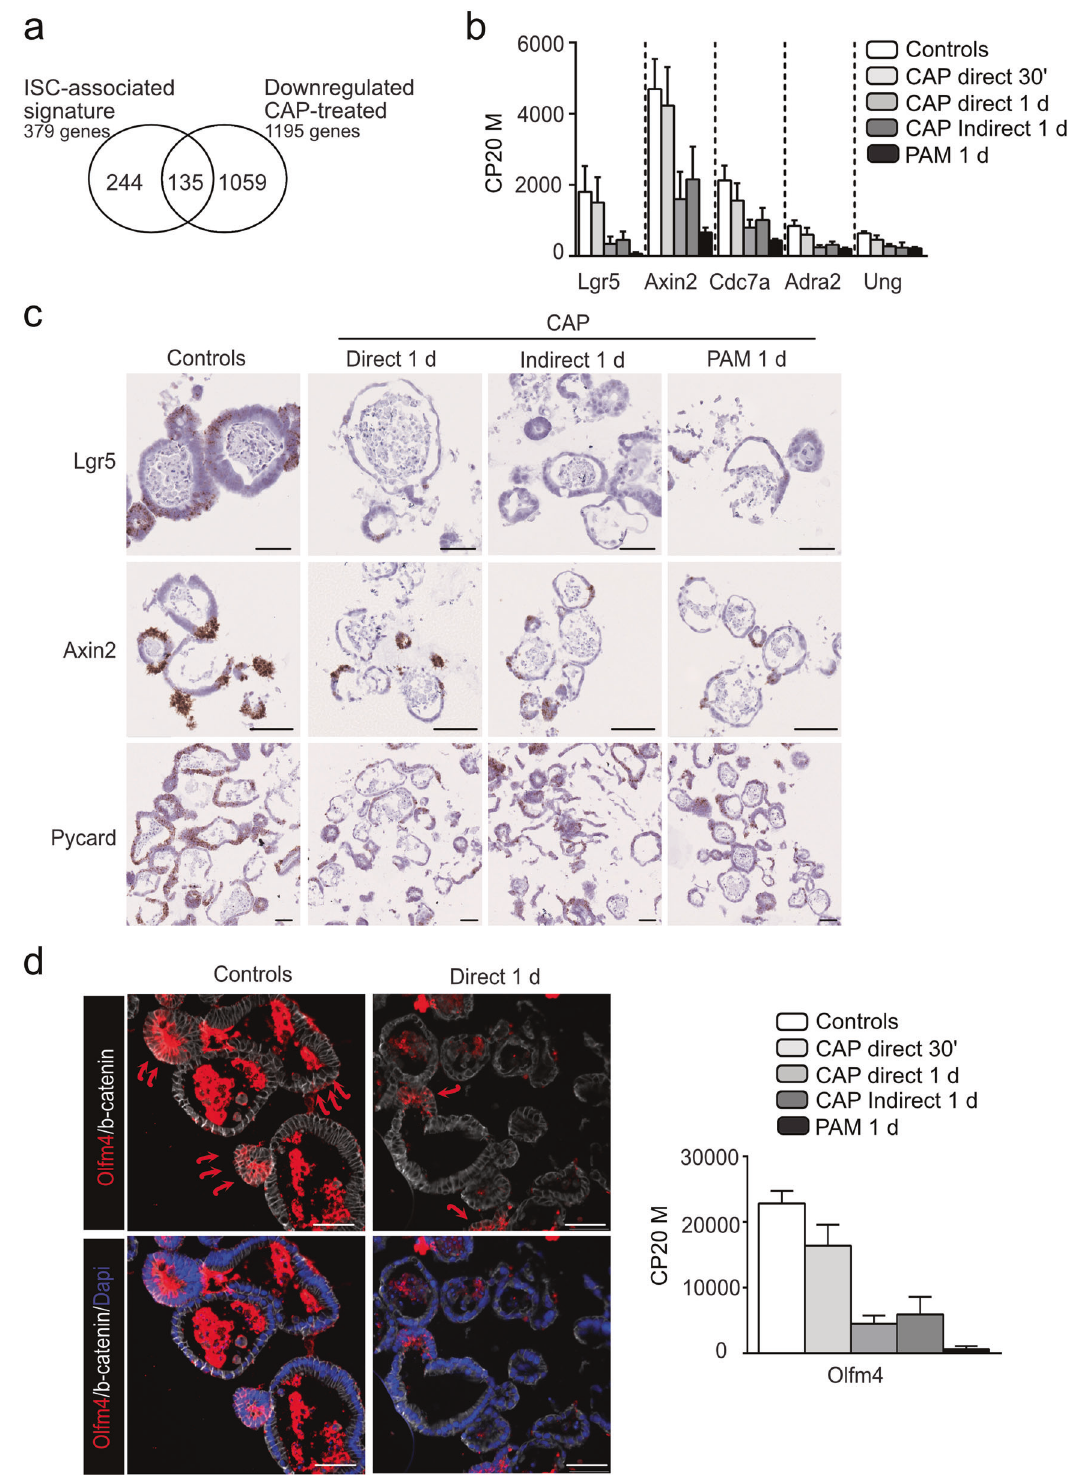
Fig. 3 CAP treatment decreases the intestinal stem cell pool. a Venn diagram showing that part of the downregulated gene list in CAP- treated samples vs controls (135 out of 1195 genes) corresponds to the ISC (Intestinal Stem Cell)-associated signature. b Expression levels of some genes of the ISC-associated signature commonly downregulated in CAP-treated organoids vs Untreated controls. CP20M: counts per kilobase of transcript per 20 million mapped reads. Data are represented as means ± sd. n = 4 and 3 samples in Controls and CAP-treated conditions, respectively. c Expression of Lgr5 , Axin2 , and Pycard genes detected in organoids by RNAscope at day 3. d Immuno fl uorescence showing Olfm4-expressing cells in organoids at day 3 (red arrows). Cell membranes were shown with β -catenin and nuclei counterstained with DAPI. Right panel: Expression levels of Olfm4 in the various conditions reported in CP20M. Scale bars: 50 µm ( c , d ).